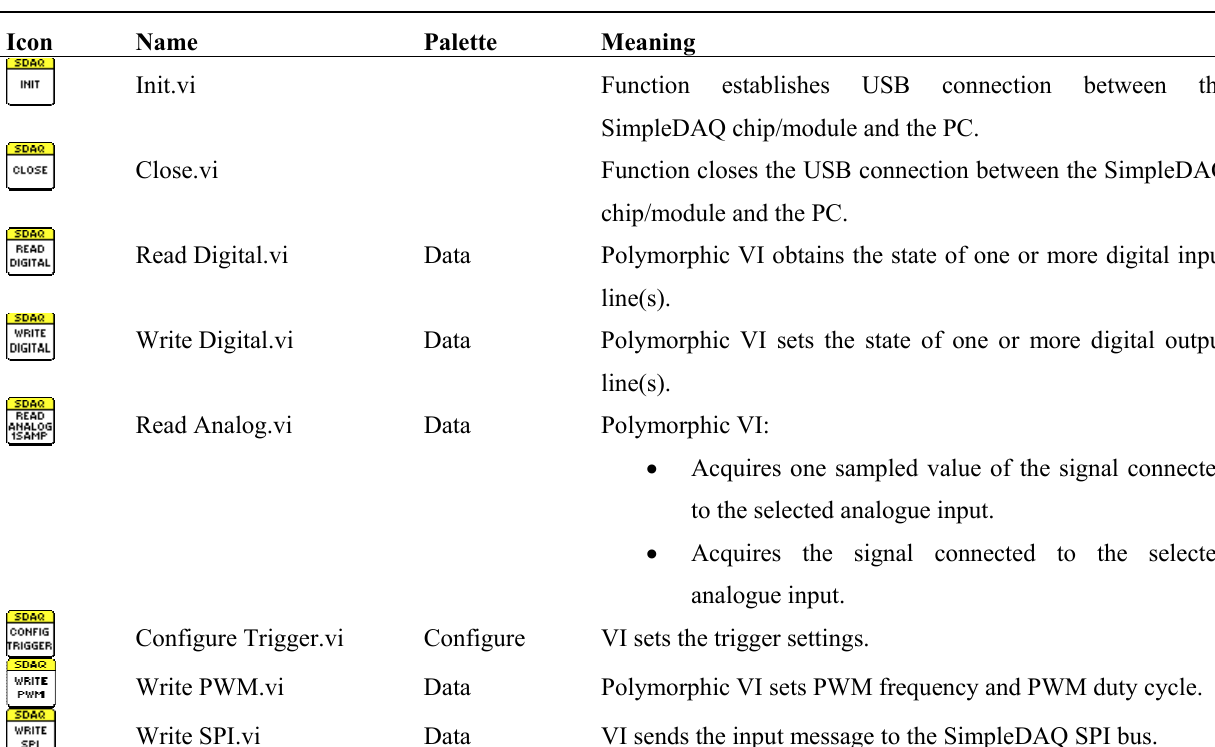
Table 5 . The meanings of the more important SimpleDAQ virtual instruments. Icon